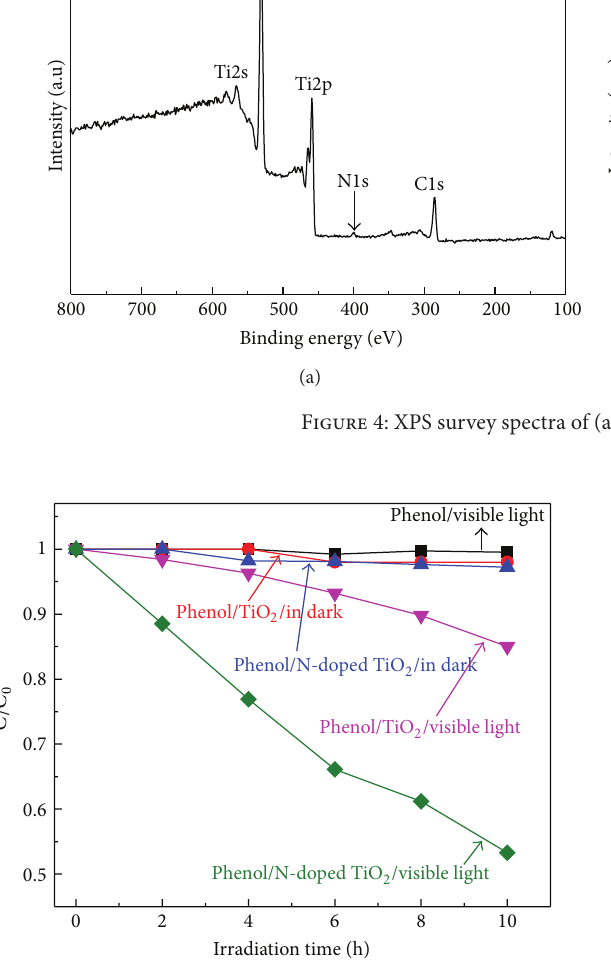
Figure 5: Photodegradation of phenol with 0.25 g catalysts at pH = 6 under different conditions.